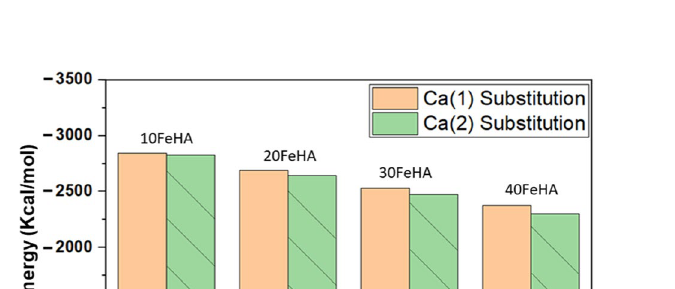
Table 1. Lattice parameters and interior angles for the unit cell of Fe-doped HA structure. Experimental values are taken from our previous study 46 . In the table, a exp /c exp denotes experimental values of lattice parameters, and a cal /c cal denotes calculated lattice parameters.